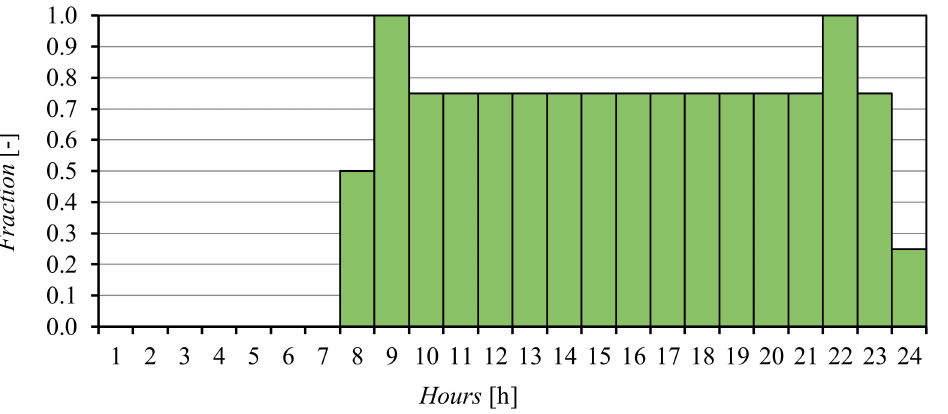
Figure 8. Daily schedule of occupation of common areas for residents of the building in the case of self-isolation.